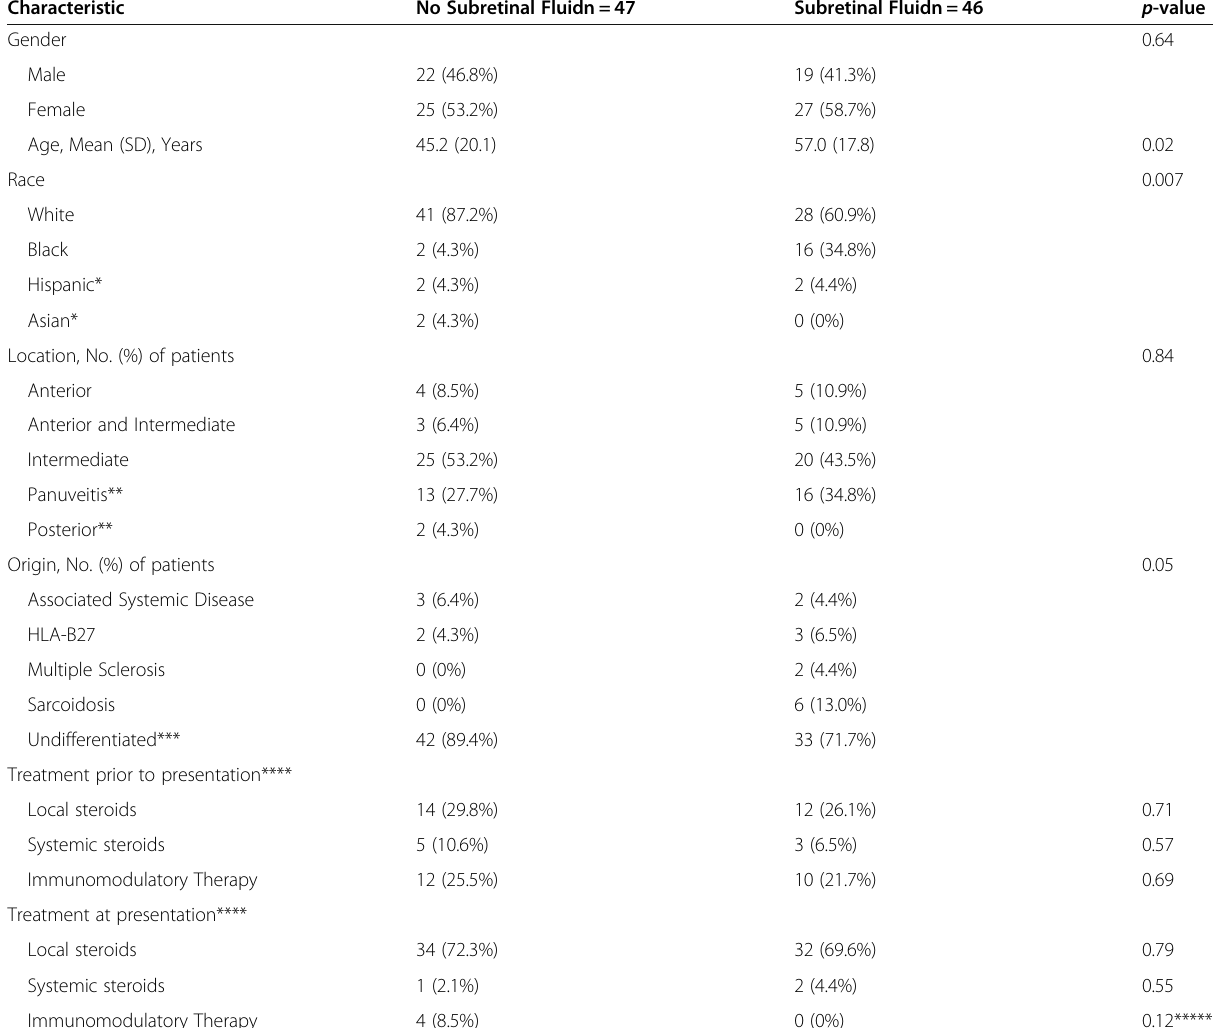
Table 1 Demographics of Eyes with Uveitic Cystoid Macular Edema, Comparing Eyes with and Without Subretinal Fluid at Presentation, N =